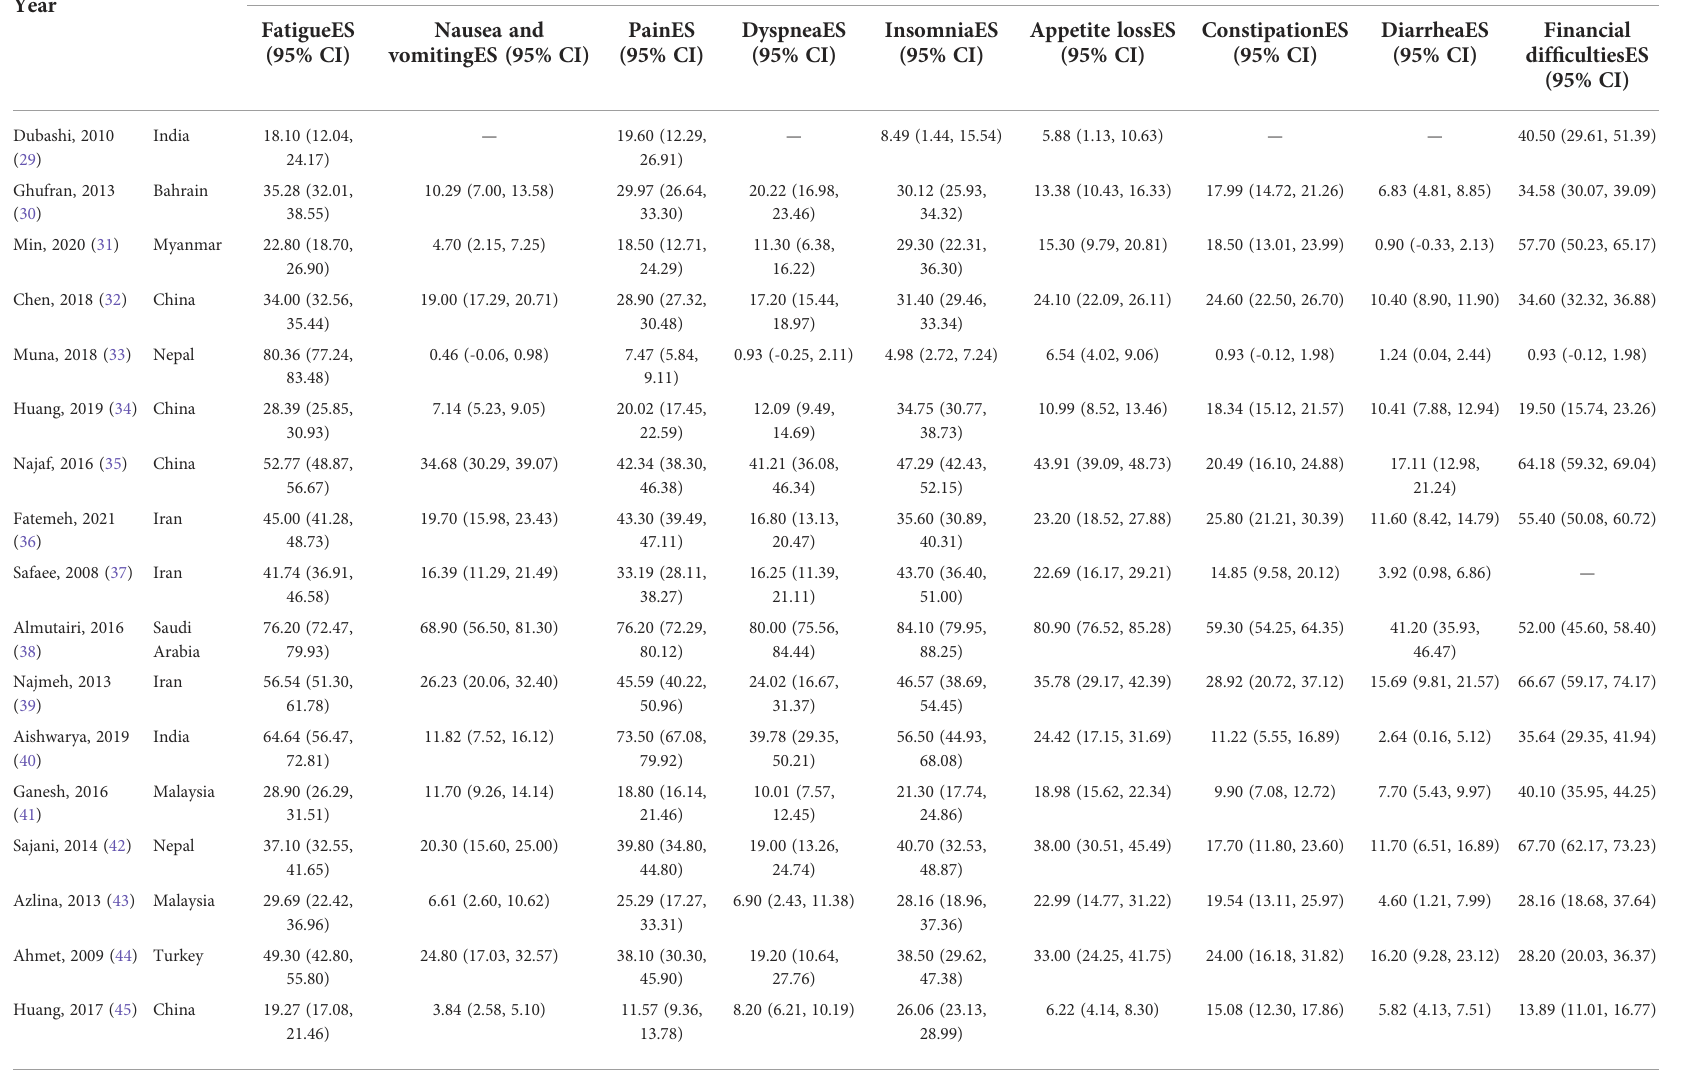
TABLE 3 Symptom subscales of EORTC